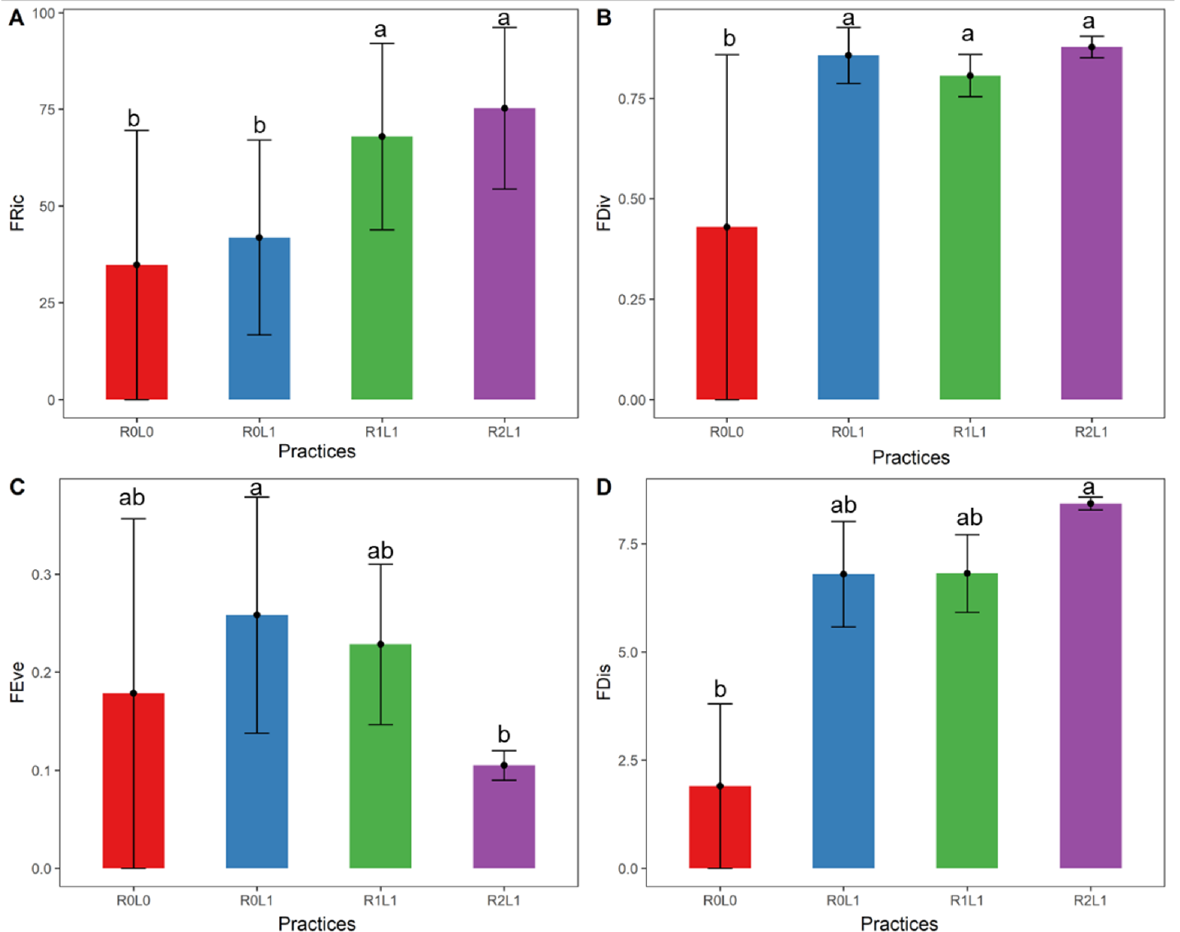
Figure 4. Average values of functional diversity indices of springtails according to practices. ( A ) FRic = functional richness; ( B ) FDiv = functional divergence; ( C ) FEve = functional evenness; ( D ) FDis = functional dispersion. Different letters indicate statistically significant differences between practices according to the Tukey test. The vertical lines represent the standard deviation for each practice ( n = 3). R0L0 — no residue or legume in the plot, R0L1 — Legume ( Pueraria phaseoloides ) only, R1L1 — Legume + stump + leaf + fine branches, R2L1 — R1L1+ trunk.